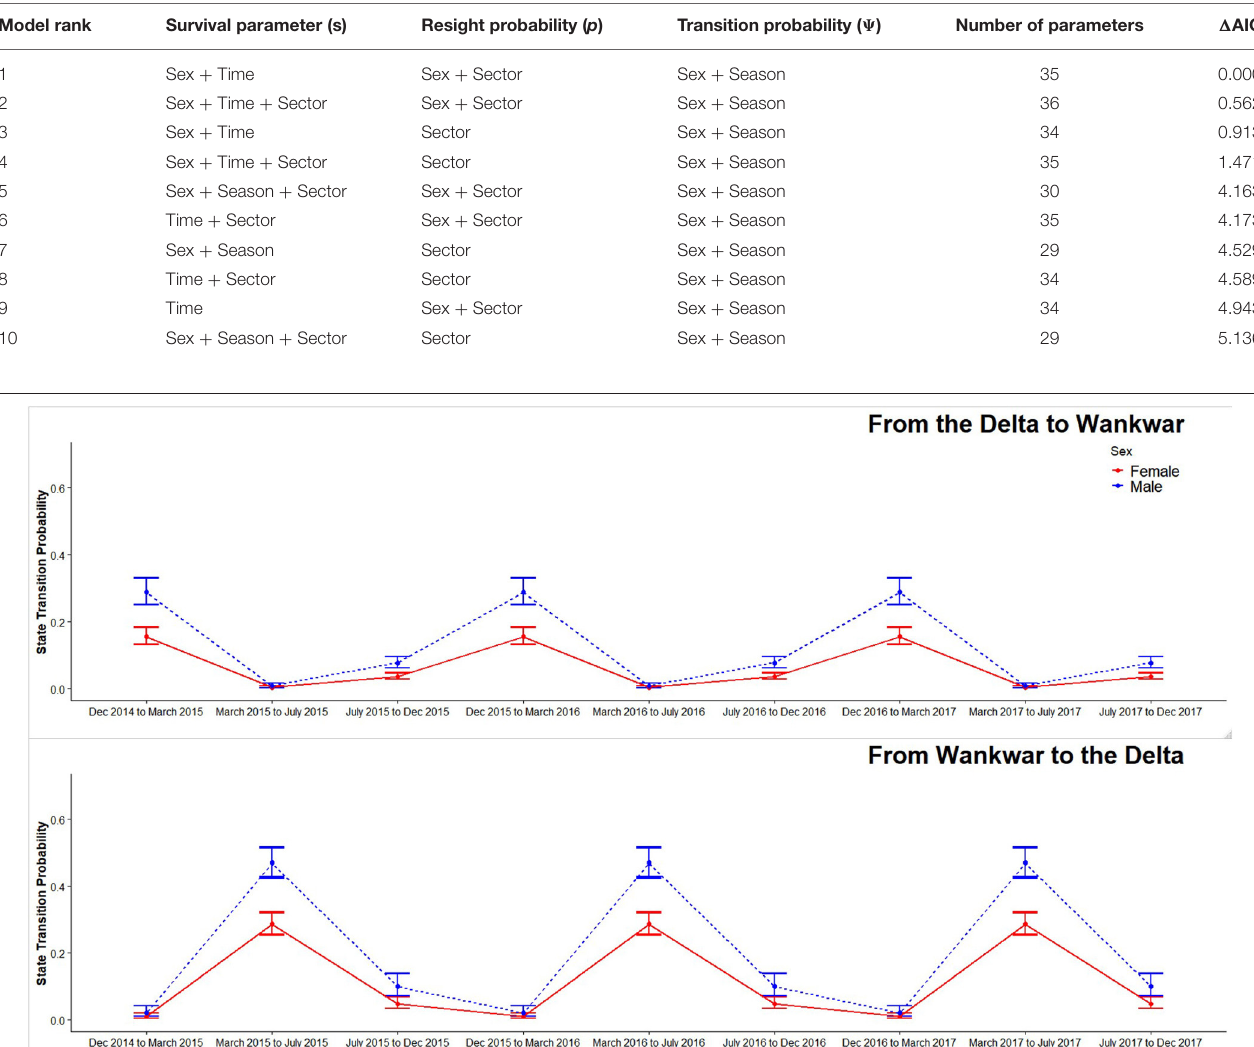
TABLE 2 | CRDMS model structure comparison of the top ten ranked models. Model rank